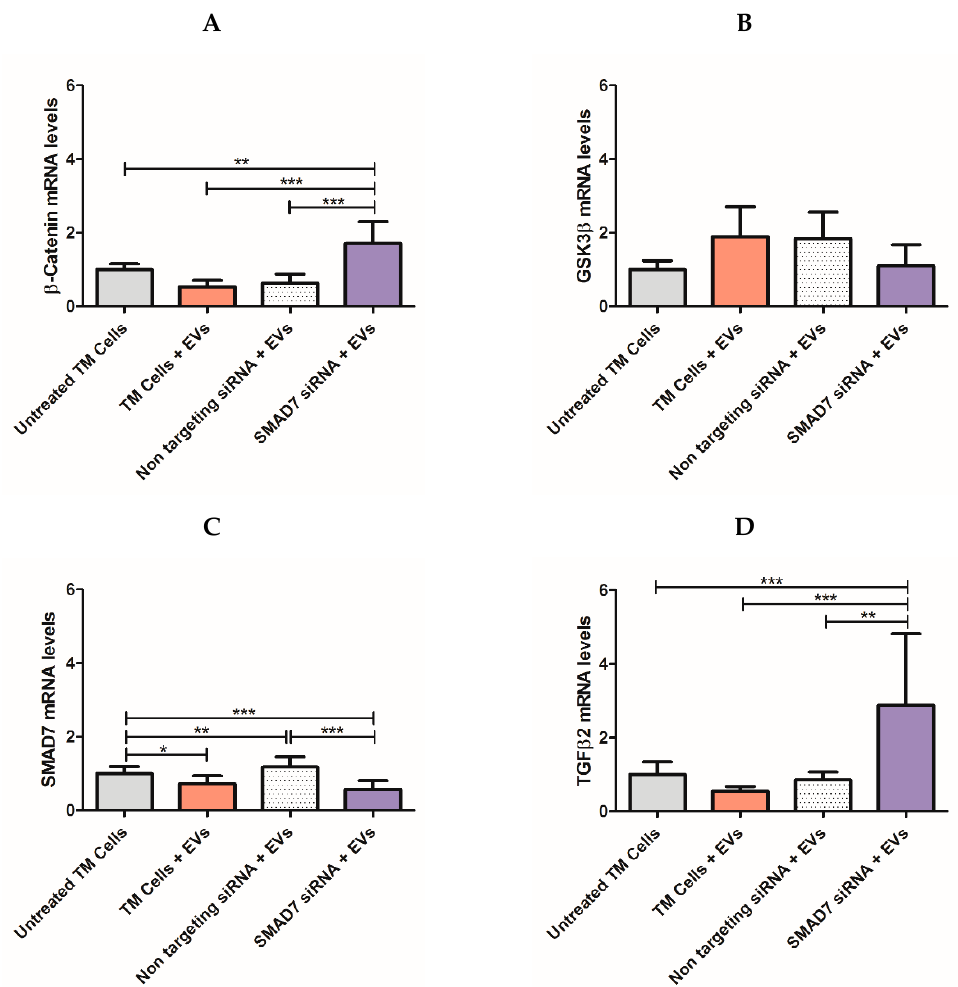
Figure 5. mRNA expression levels of Wnt-TGF β 2 signaling components using qRT-PCR analysis. Real-time qRT-PCR was performed to examine the mRNA expression levels of canonical WNT-TGF β 2 signaling components, including the Wnt transducers β -Catenin ( A ), total GSK3 β ( B ), SMAD7 ( C ), and TGF β 2 ( D ). Data were normalized to the average mRNA level of GAPDH. One-way ANOVA analyses were used to study the effect of different TM cells treatments on Wnt-TGF β 2 genes expression. Data represent means ± SD from three independent experiments performed in triplicates. One-way ANOVA was used to determine statistical difference, as indicated by asterisks (* p < 0.05, ** p < 0.01, *** p < 0.001).